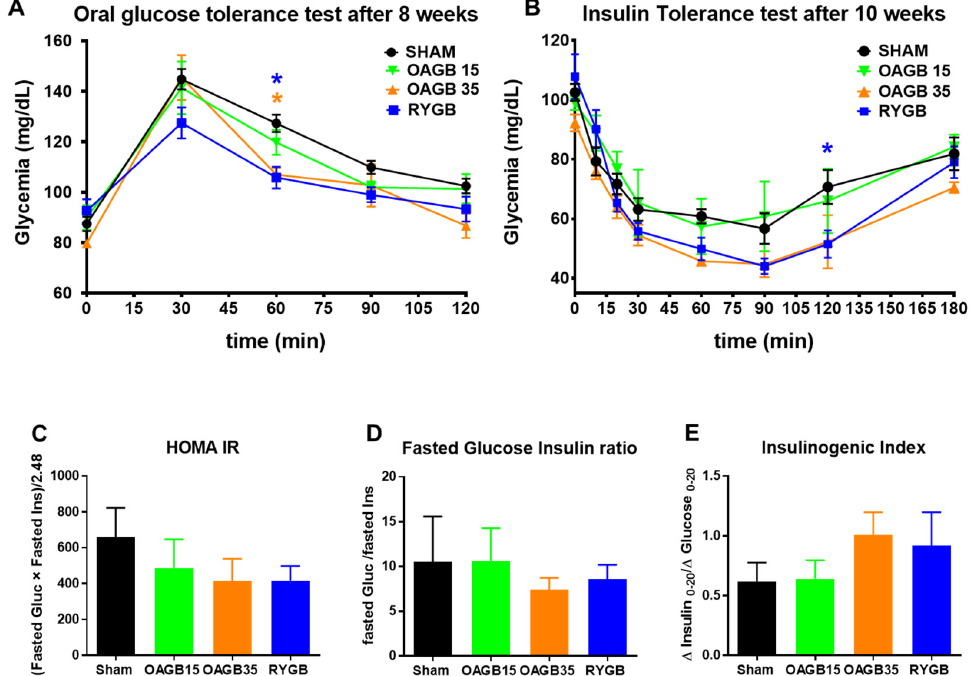
Figure 3. Shortening the BPL of OAGB affects insulin sensitivity in obese rats . ( A , B ) Glycaemia during an oral glucose tolerance test performed on week 8 post-surgery ( A ) or during an insulin tolerance test performed on week 10 post-surgery ( B ). * p < 0.05; for OAGB-35 (orange) or RYGB (blue) vs. Sham (black) by Dunnett’s multiple comparison tests after 2-way RM ANOVA. ( C ) Calculated HOMA-IR [(Fasted Glucose × Fasted Insulin)/2.48], ( D ) Fasted insulin over Fasted Glucose Ratio and ( E ) Insulinogenic index ( ∆ Insulin 0–20 / ∆ Glucose 0–20 ). No statistical difference was observed after a Kruskal–Wallis Test. Data are expressed as means ± SEM, SHAM n = 6, RYGB n = 6, OAGB15 n = 5, OAGB35 n =